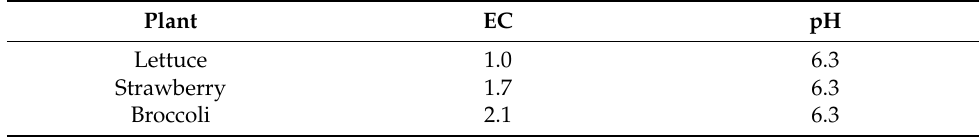
Table 3. The required EC and pH for different